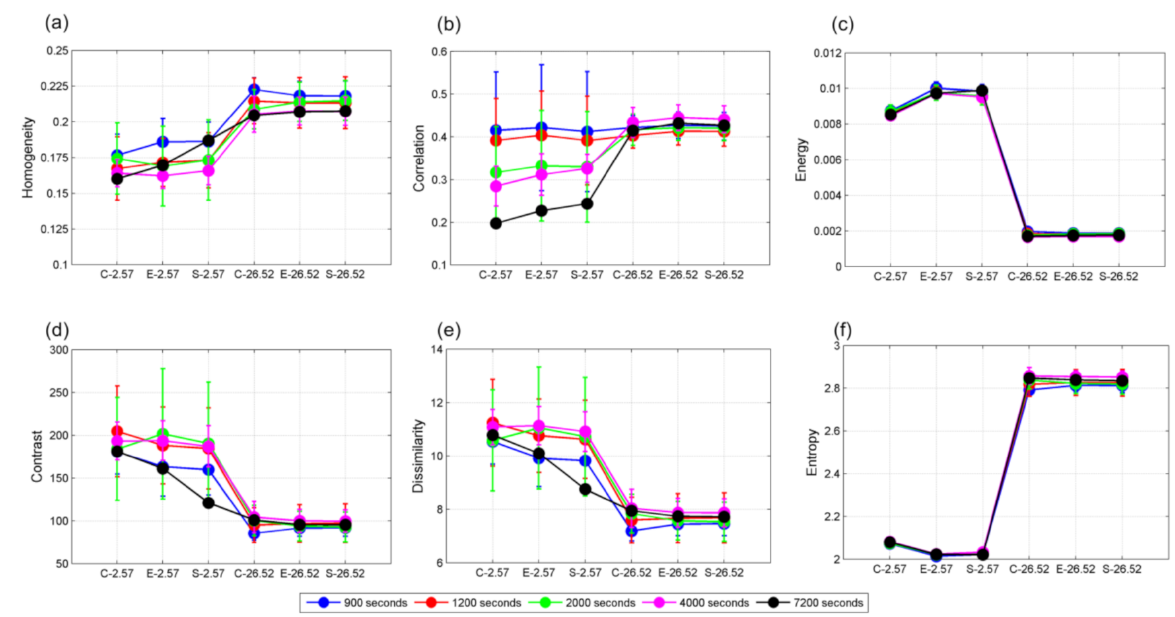
Figure 10. Six textural features vs. lesions with different shapes and volumes placed in the background for contrast 2:1 and quantization level 64. C-2.57, E-2.57, and S-2.57 represent 2.57 cm 3 cylindrical, ellipsoidal, and spherical volumes, respectively. C-26.52, E-26.52, and S-26.52 represent 26.52 cm 3 cylindrical, ellipsoidal, and spherical volumes, respectively. ( a ) Homogeneity, ( b ) contrast, ( c ) energy, ( d ) contrast, ( e ) dissimilarity and ( f )